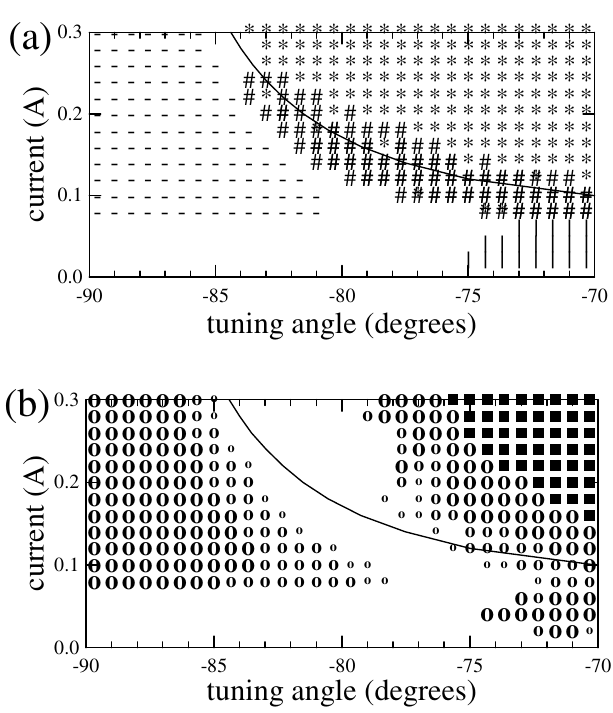
FIG. 5. Modeling for the new MAX-II 100-MHz/500-MHz rf system with worst-case parasitic coupled-bunch instability. A curve shows the parameters for optimal bunch lengthening. (a) Analytic predictions. –: parasitic coupled-bunch instability; |: coupled-dipole Robinson instability; *: coupled-quadrupole Robinson instability; #: fast dipole-quadrupole mode-coupling Robinson instability. (b) Results of 500 000-turn simulations of 120 000 macroparticles. o: mild instability, where the energy spread exceeds its natural value by (10–30)%; o : moderate instability, where the energy spread has increased by (30– 100)%; O : strong instability, where the energy spread has increased more than 100%; (cid:1) : lost